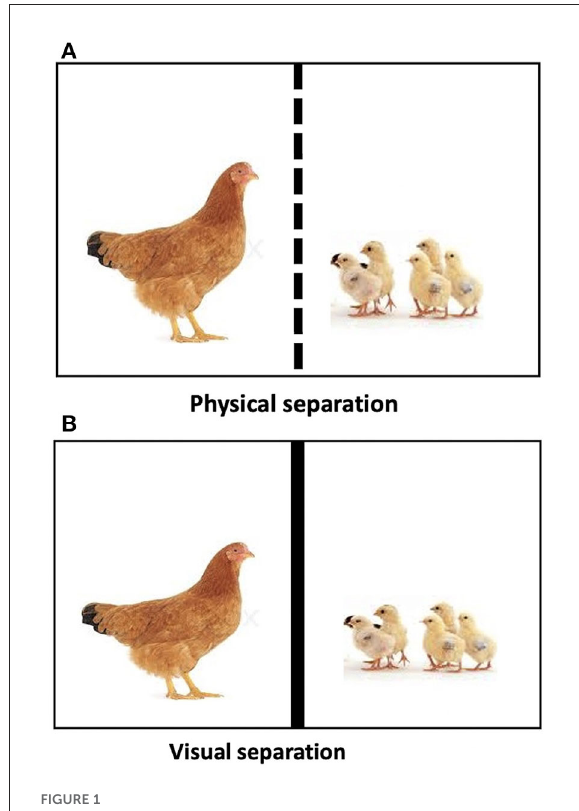
FIGURE1 (A) Hen-chicks’ pair subjected to physical separation in a test arena. (B) Hen-chicks’ pair subjected to visual separation in a test arena.